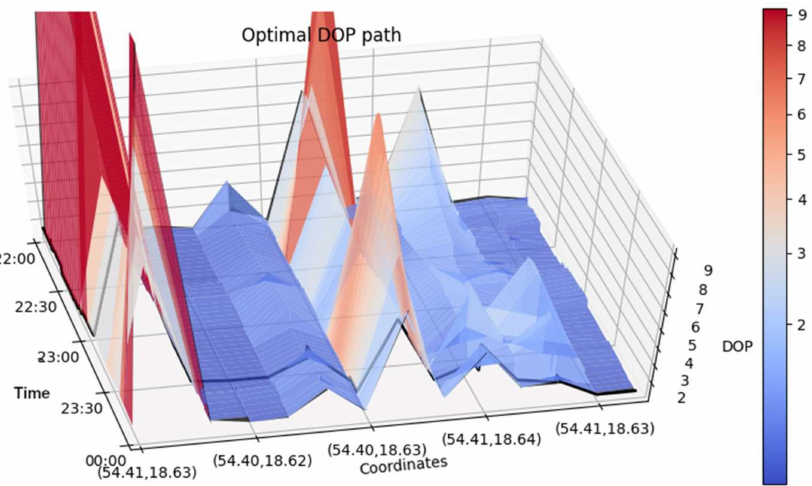
Figure 4. Diagram of the optimal 3D route. The surface presents DOP values for specific coordinates and at a specific time. The black line is an optimal route.